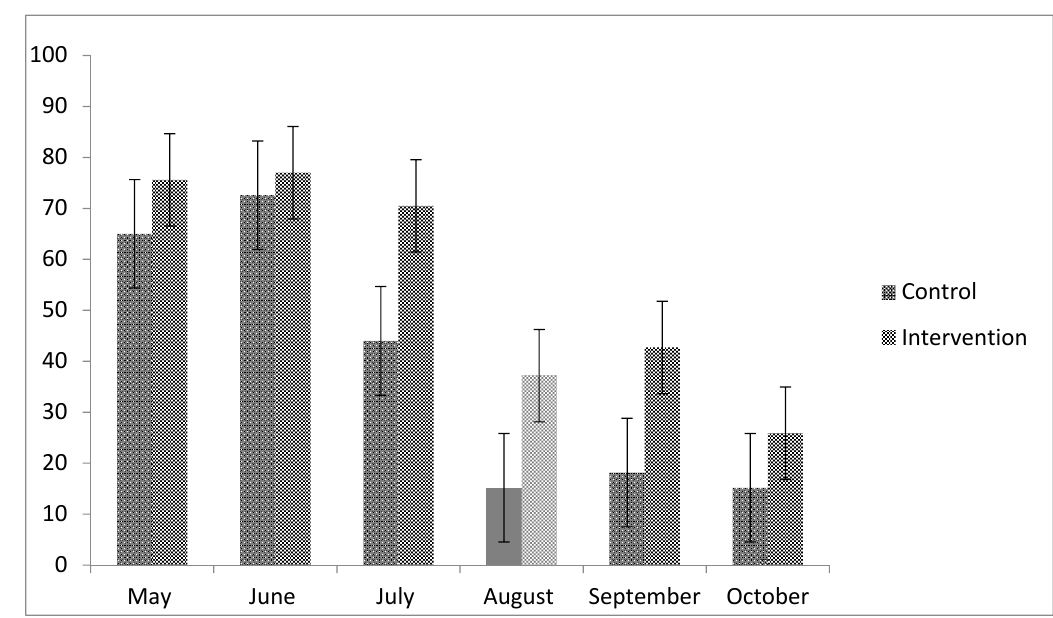
Figure 1. Percentage of high-intensity interval training (HIIT) exercise sessions attended (depicted with 95% confidence intervals). Note that summer vacation started at the beginning of August (lighter color to indicate summer